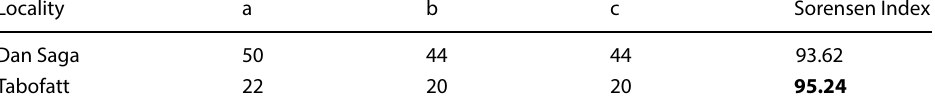
a = number of species in plots with practices, b = number of species in control plots, c = number of